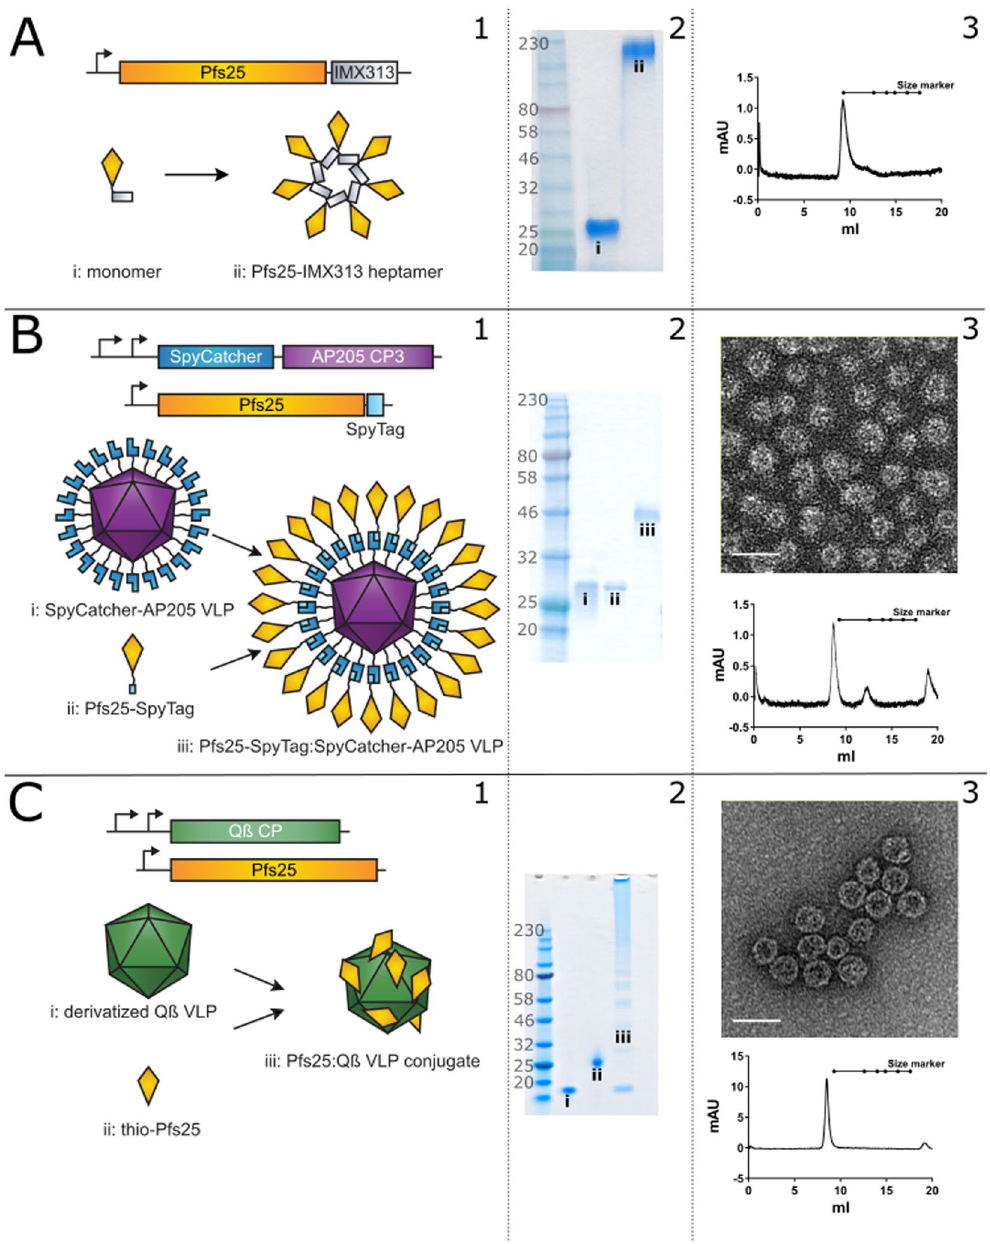
Figure 1. Generation and characterisation of nanoparticles used in this study. ( A ) Pfs25-IMX313 (1). Schematic of construct design particle and formation illustrating monomer (i) and heptamer (ii). (2) SDS- PAGE showing reduced monomer (i) and non-reduced heptamer (ii). (3) Size exclusion chromatography trace illustrating heptamer migration in the expected range. ( B ) Pfs25-SpyTag:SpyCatcher-AP205 (1) Schematic of construct design and particle formation illustrating SpyCatcher-AP205 (i), Pfs25-SpyTag (ii), and Pfs25-SpyTag:SpyCatcher-AP205 conjugate (iii). (2) Reducing SDS-PAGE showing SpyCatcher-AP205 (i), Pfs25-SpyTag (ii), and Pfs25-SpyTag:SpyCatcher-AP205 conjugate (iii). (3) Negatively stained TEM of Pfs25-SpyTag:SpyCatcher-AP205, scale bar = 50 nm and size exclusion chromatography trace illustrating VLP migration in the expected range. ( C ) Pfs25-Q β (1) Schematic of construct design and particle formation illustrating Q β VLPs (i), Pfs25 (ii), and Pfs25-Q β conjugate (iii). (2) Reducing SDS-PAGE showing Q β VLPs (i), Pfs25 (ii), and Pfs25-Q β conjugate (iii). (3) Negatively stained TEM of Pfs25-Q β VLPs, scale bar = 50 nm and size exclusion chromatography trace illustrating VLP migration in the expected range. Numbers at the left of the coomassie images represent size in kDa. Size markers in all size exclusion traces are from left to right: 670, 158, 75, 44, 29 and 13.7